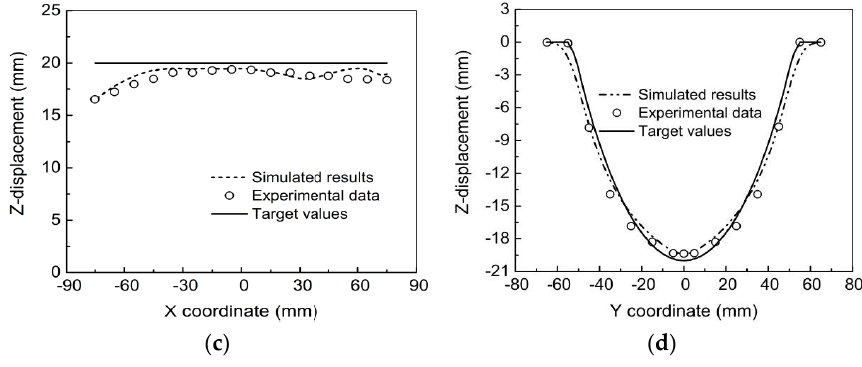
Figure 13. Comparison of Z -displacement between experimental and simulated results along X center web-bottom path ( a , c ) and Y center web-bottom path ( b , d ): ( a , b ) after the first station; and ( c , d ) after the second station.